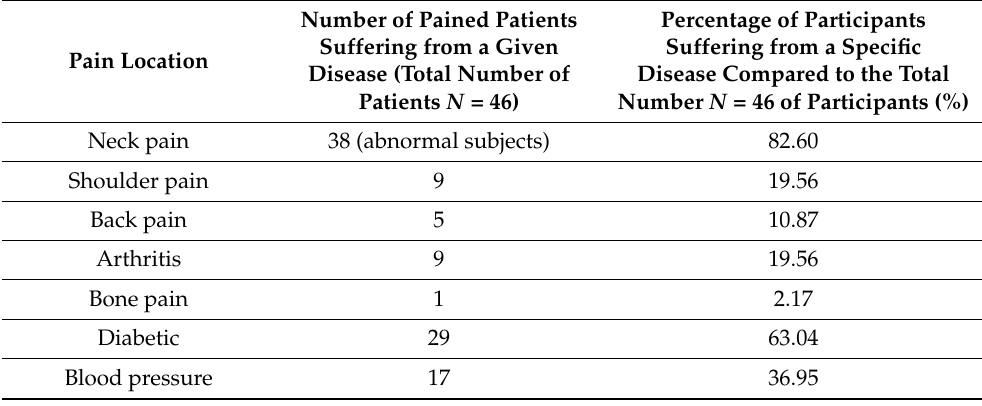
Table 2. Pain location and the number of painful patients who participated in the study (total number of participants N = 46).